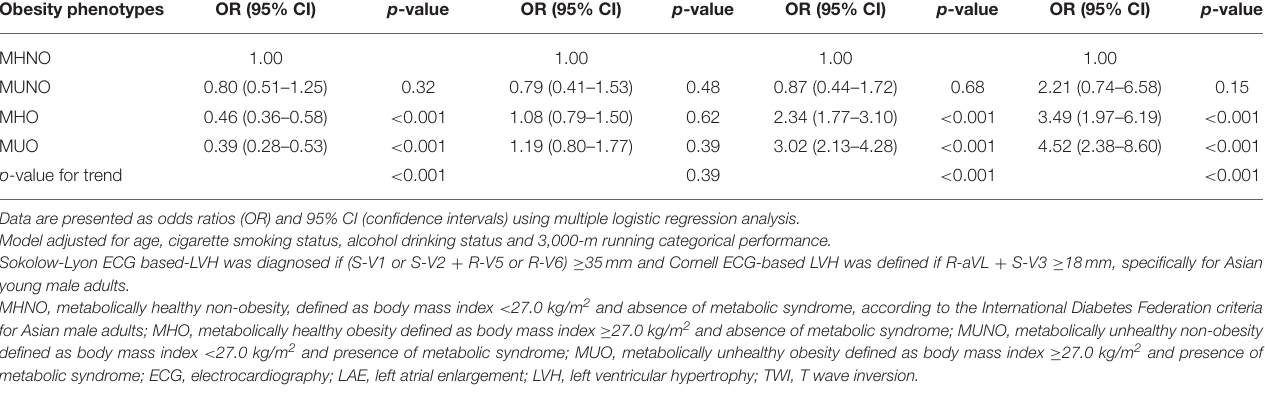
TABLE 4 | Associations of specific ECG characteristics and metabolic components with ECG-LVH in the obese and non-obese. Sokolow-Lyon based ECG-LVH Cornell based ECG-LVH Non-obesity Obesity Non-obesity Obesity